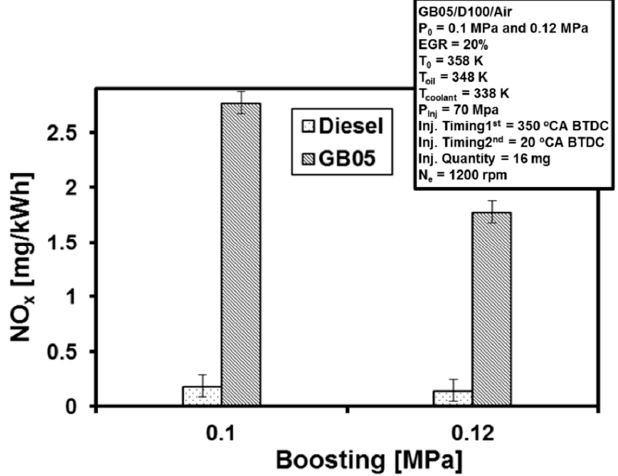
Figure 13. Effect of intake boosting on NOx emissions in MPCI mode.